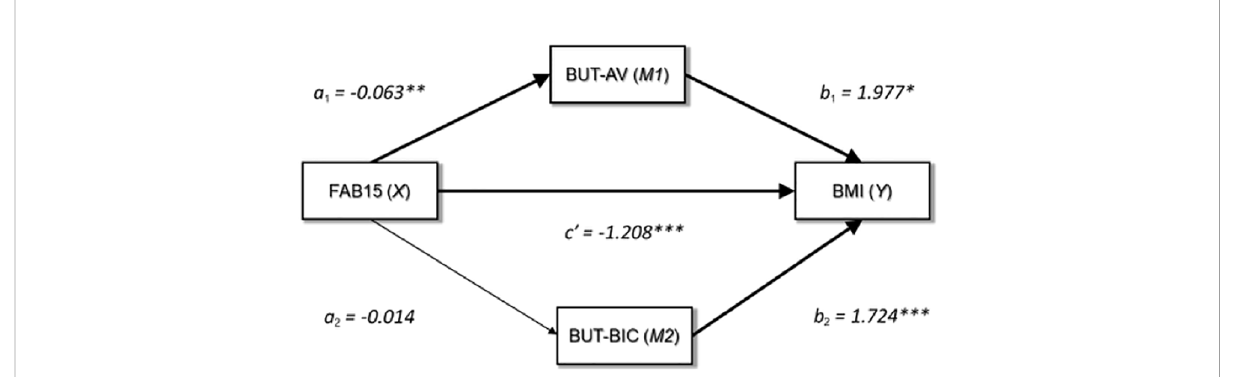
FIGURE 1 Graphical representation of the medication analysis output. FAB15, frontal assessment battery-15; BUT-AV, BUT-Avoidance; BUT-BIC, BUT-Body Image Concerns; BMI, body mass index; *p = <0.05; **p = <0.01; ***p =